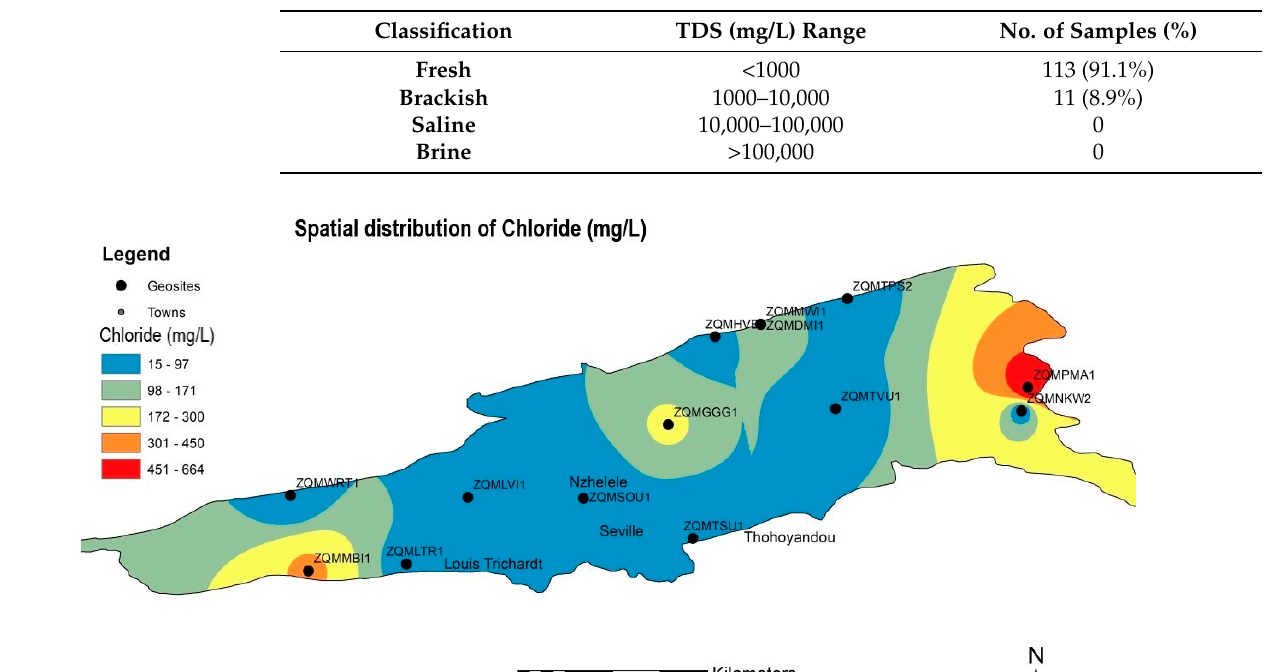
Table 3. Classification of groundwater based on TDS [42].